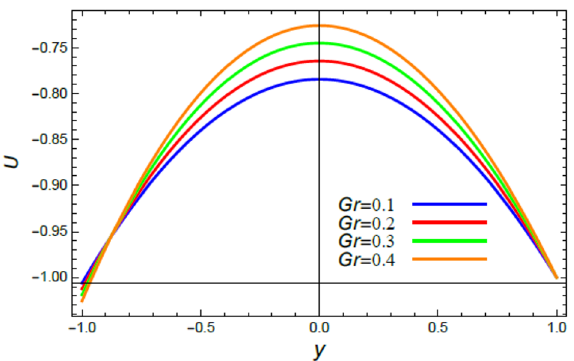
Figure 3. The influence of the Grashof numeral Gr on the speed profile u .